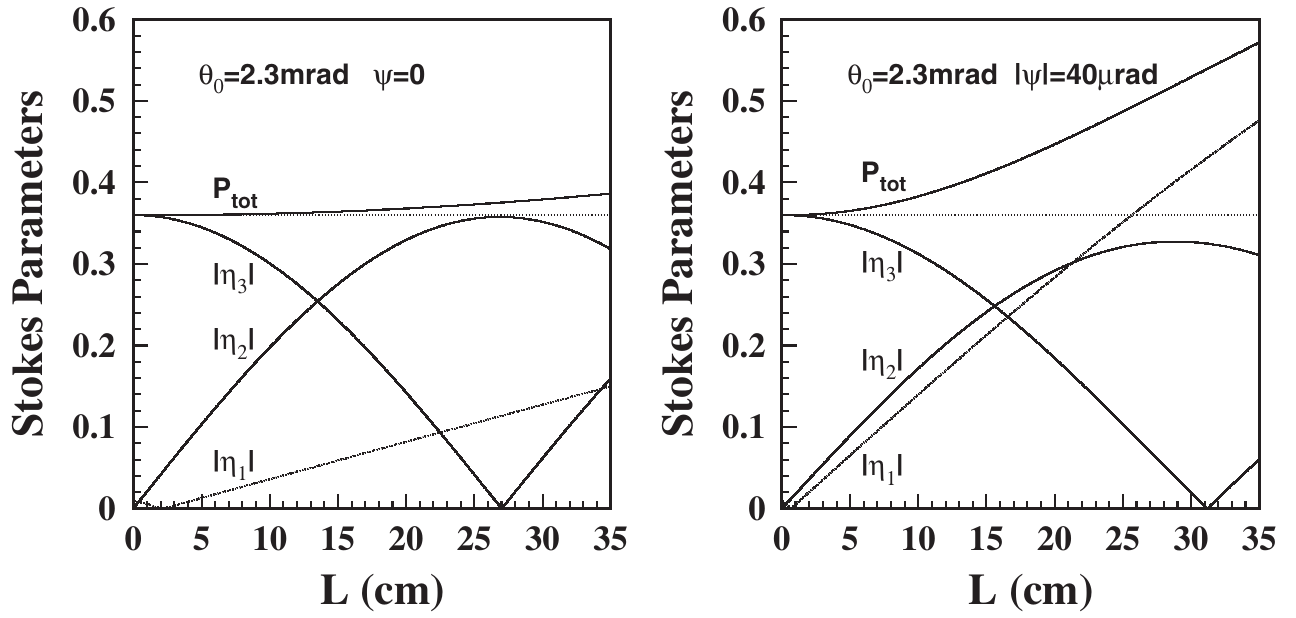
FIG. 8. (Color) Absolute values of the Stokes parameters and the total degree of polarization for a Si crystal as a function of its (cid:2) 100 GeV linearly polarized photons. The left-hand figure and the right-hand figure are calculated using initial thickness L , for E (cid:1) values for the Stokes parameters described in the text. For these conditions, the crystal also acts as polarizer generating a (cid:2)